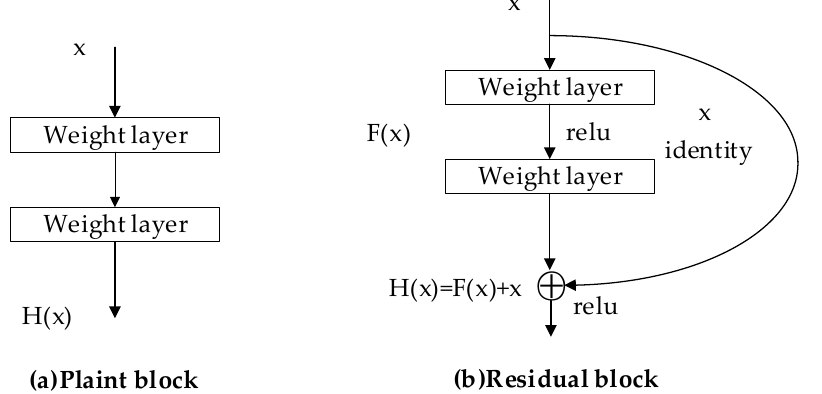
Figure 4. Structures of convolutional blocks: ( a ) the plaint block; ( b ) the residual block.